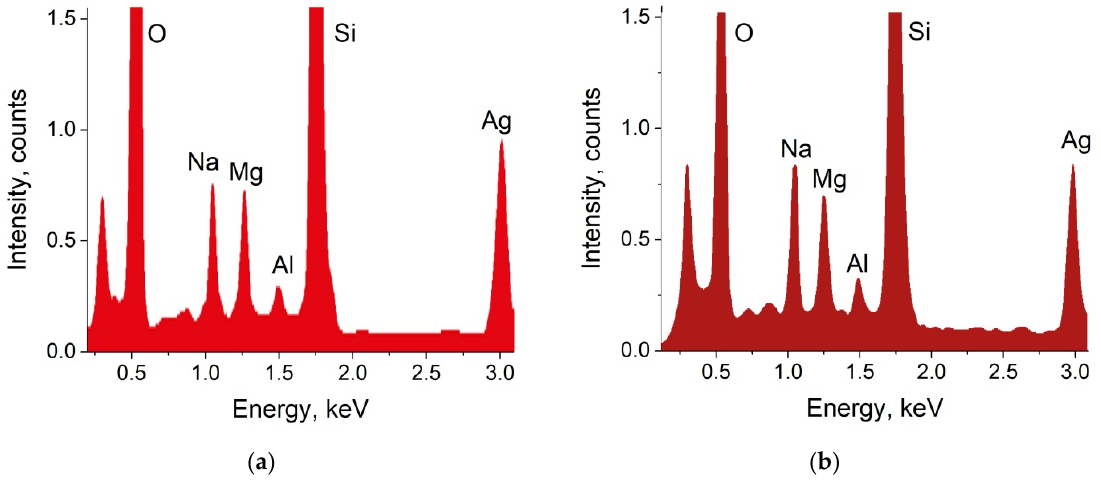
Figure 2. EDX spectra obtained from the prepared sample ( a ) and the same sample after 1 day exposure to PBS ( b ).